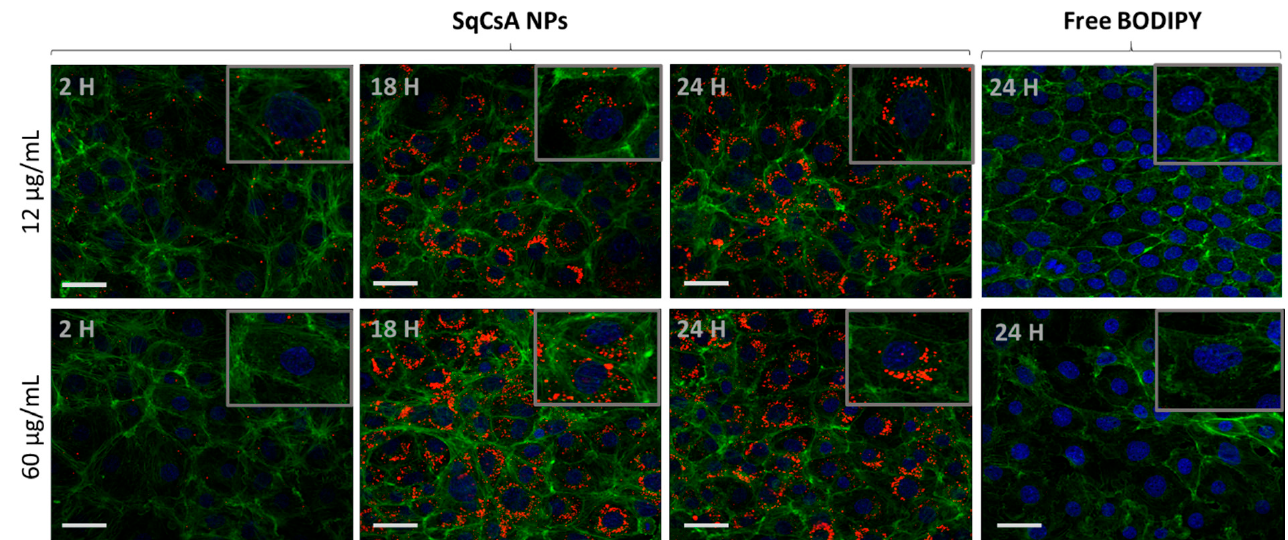
Figure 7. SqCsA NPs uptake assessment. The MCEC cell line was incubated with two concentrations of nanoparticles 12 or 60 µg/mL loaded with CholEsteryl BODIPY™ (red). After different times, cells were rinsed, fixed, and incubated with phalloidin (green). The cells were mounted with medium containing DAPI (blue), analyzed under confocal microscope, and imaged. Cells incubated with only CholEsteryl BODIPY™, at an equivalent concentration to 60 µg/mL of NPs, were used as control and imaged at 24 h. Insert 90× magnification. Scale bar = 50 µm.